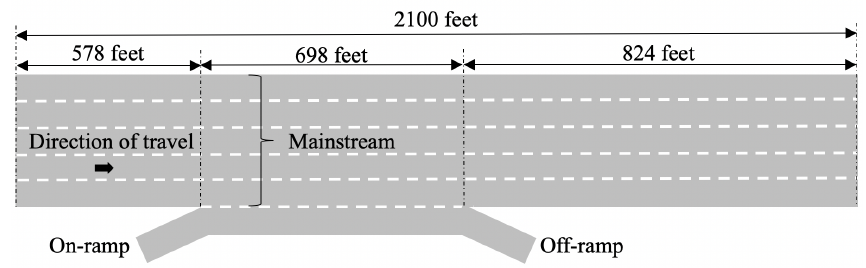
Figure 8. Description of measurement area: the proposed method was trained and evaluated using a real traffic dataset acquired at US-101. The measurement area was 2100 feet long, and there are five mainstream lanes. The acceleration lane is 698 feet long. On and off-ramps exist within the measurement area. If drivers on the acceleration lane fail to perform the lane-changing until the end of lane, they should go out through